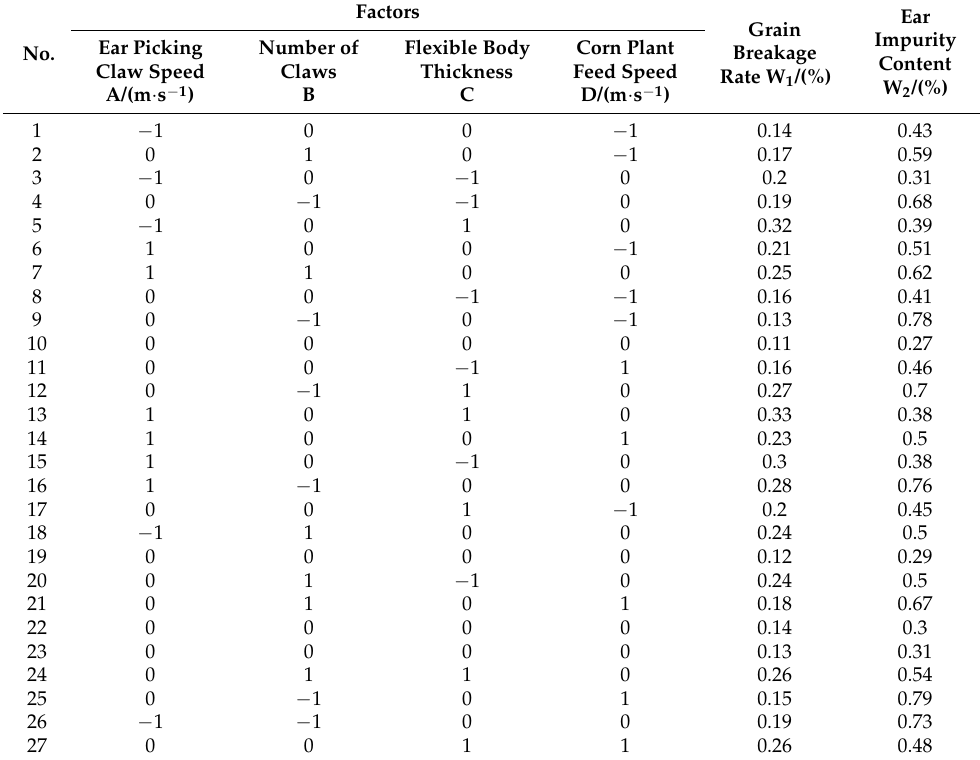
Table 4. Program and results of the test of the quadratic rotation–orthogonal